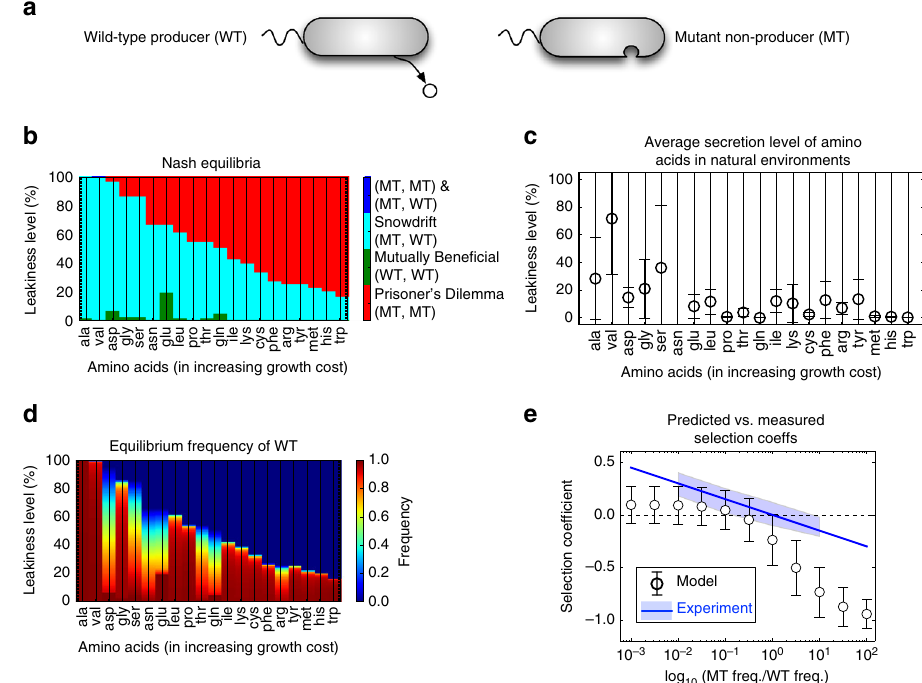
Fig. 3 Metabolic dependencies in populations of E. coli secreting one amino acid. a Possible genotypes in populations of E . coli leaking an amino acid include a prototrophic wild-type strain (WT) self-synthesizing a leaky amino acid and a mutant strain (MT) lacking the gene(s) for the biosynthesis of this amino acid. b The identi fi ed Nash equilibria for various leakiness levels (as a percentage of an in silico determined maximum: see Supplementary Methods) across all 20 amino acids. Amino acids are shown here by using their standard three-letter code in the order of increasing in silico growth cost (see also Supplementary Fig. 1). c Experimentally reported leakiness levels of amino acids averaged over three different data sets 37,38 . Values in each data set were normalized to their maximum (see Supplementary Data 2 for values of data). Error bars show standard deviation over the three data sets. d The equilibrium frequency of WT as a function of the leakiness level and amino acid type. In silico invasion experiments for two cases of MT invading WT and WT invading MT revealed that the equilibrium frequencies are insensitive to the initial frequencies (results are shown here for only one case). e Predicted selection coef fi cients across all amino acids and leakiness levels vs. the experimentally reported ones for E . coli 39 . Empty circles and error bars show, respectively, the average and the range (i.e., minimum and maximum) of the computed selection coef fi cients across all amino acids and leakiness levels. The blue line and the shaded region around it show the line fi tted to experimentally measured selection coef fi cients and their range (from ref. 39 , amino acid-de fi cient regime),